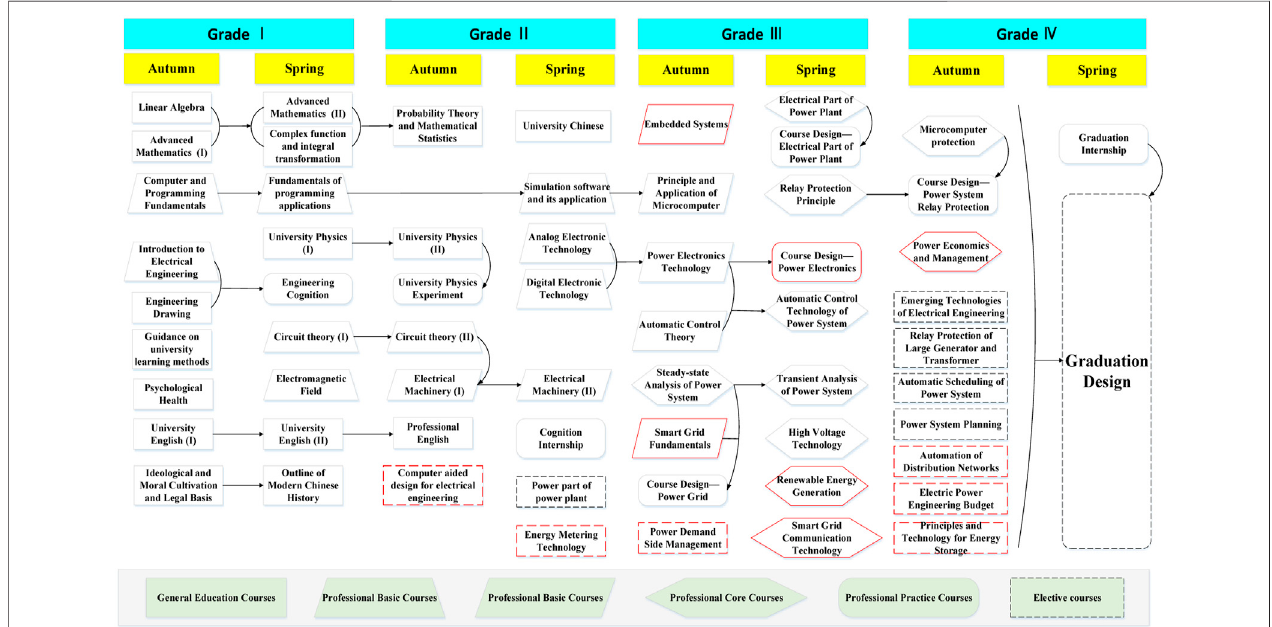
FIGURE 1 | The overall curriculum system for concentration in Smart grid Information